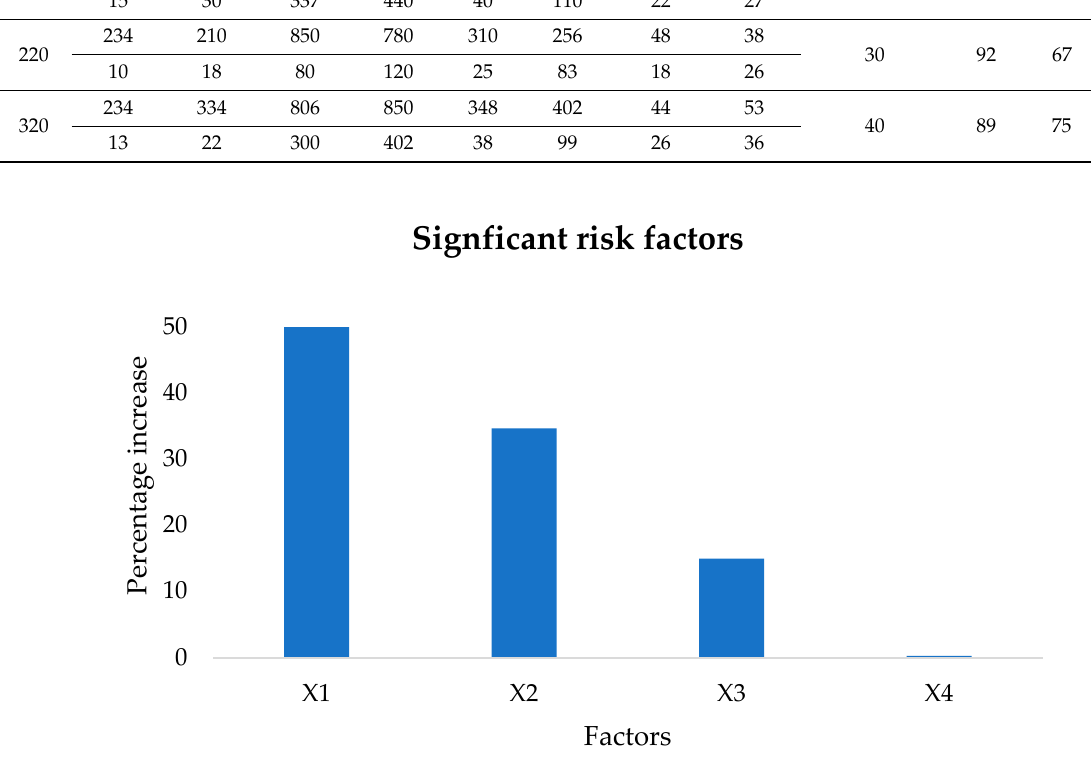
Figure 10. Significant risk factor identification, where X1, X2, X3 and X4 denote operator errors, improper design, emergency reservoir tank failure and high inflow rate, equipment service failure, and wet weather conditions, respectively.